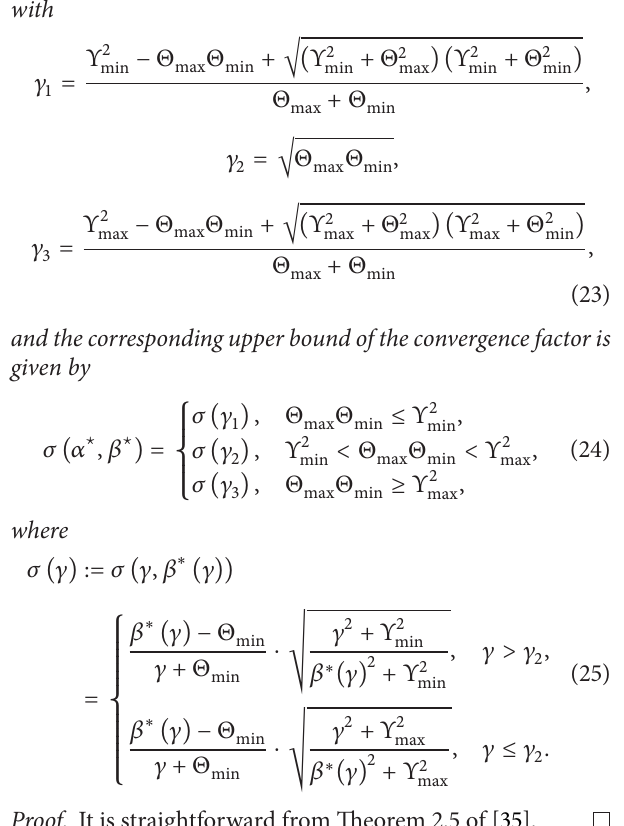
Algorithm 9 (the IGHSS iteration method). Given an